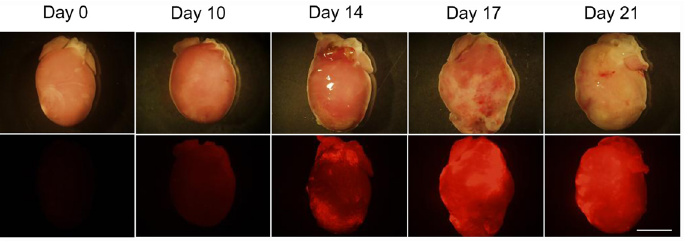
Fig 2. Time-course changes in vascular permeability in myocarditic hearts in the rat EAM model. The representative brightfield and fluorescent images of the myocarditic hearts of rats that received fluorescent- labeled nano-sized beads (100 nm) are shown in the upper and lower panels, respectively. Hearts were excised on days 0, 10, 14, 17 and 21 after immunization. In each time point, 2 – 3 rats were checked. Bar indicates 10